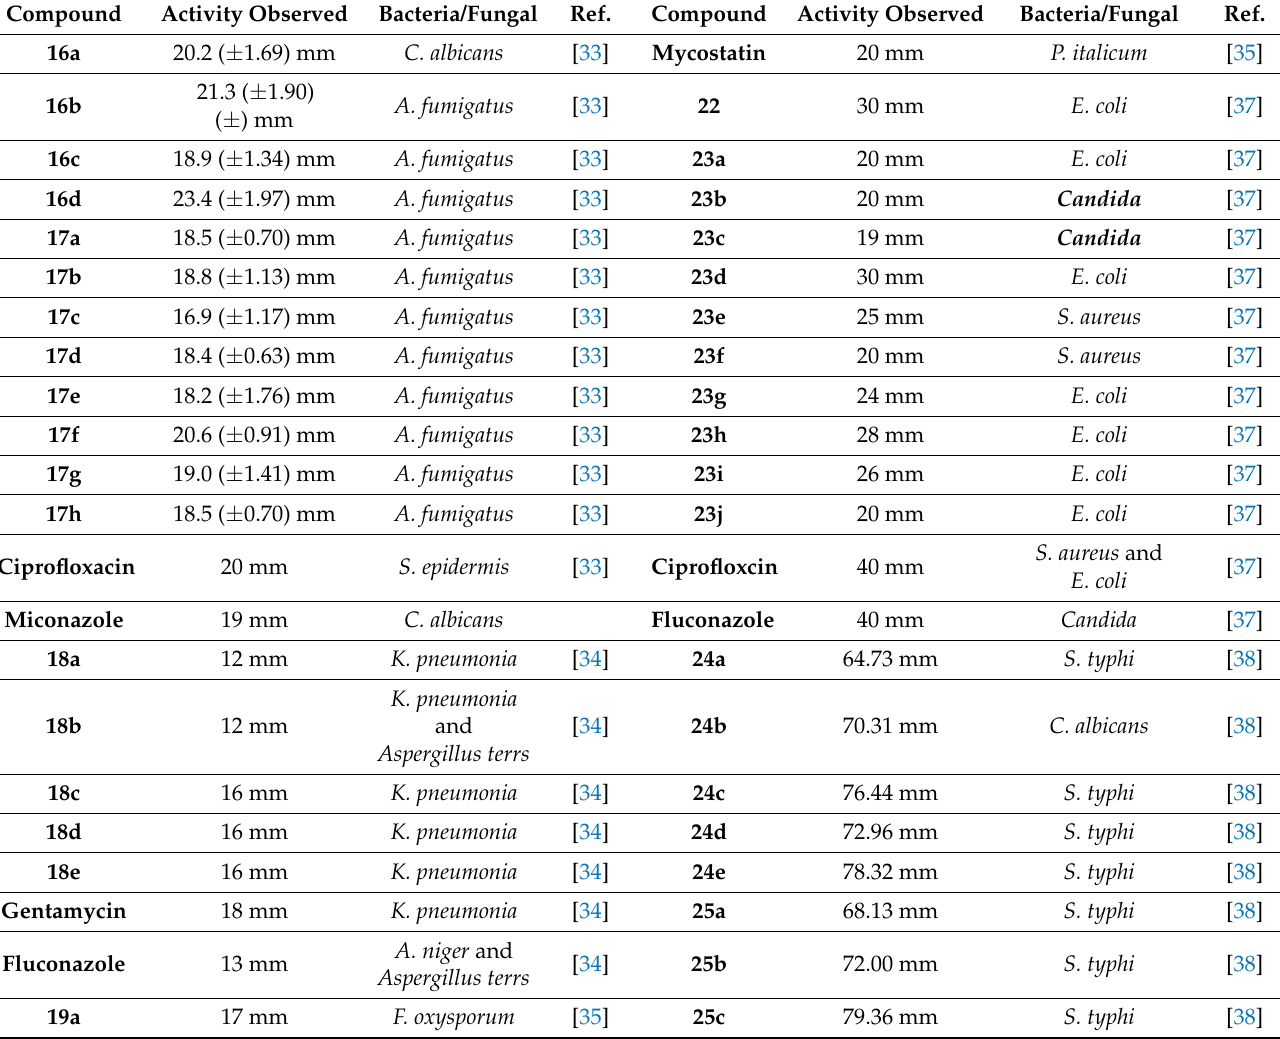
Table 2. Antimicrobial activity data of reported coumarin triazole